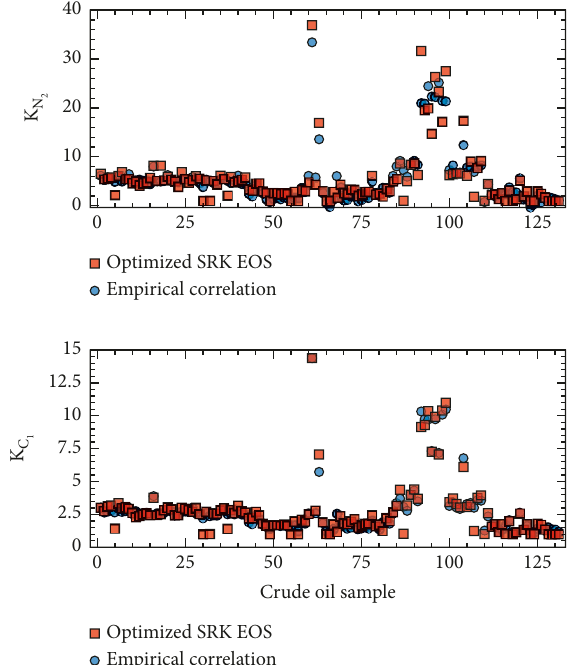
Figure 4: Comparison of equilibrium constants calculated with the Soave–Redlich–Kwong EOS and the proposed empirical